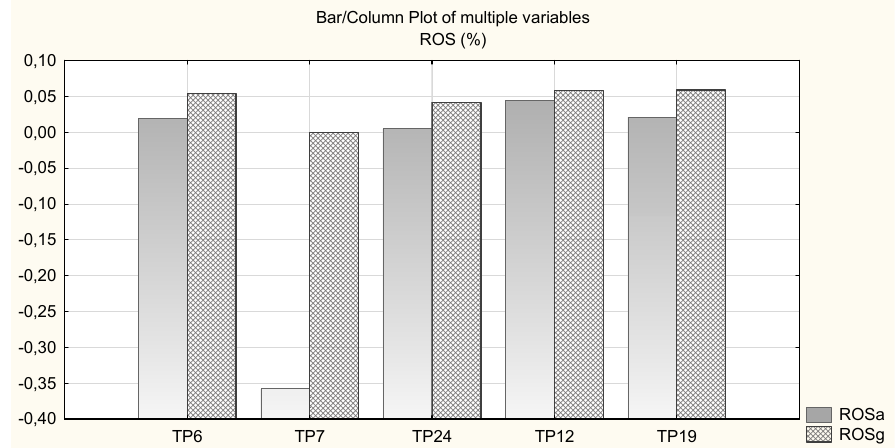
Fig. 4. Comparison of the actual and goal values of the ROS